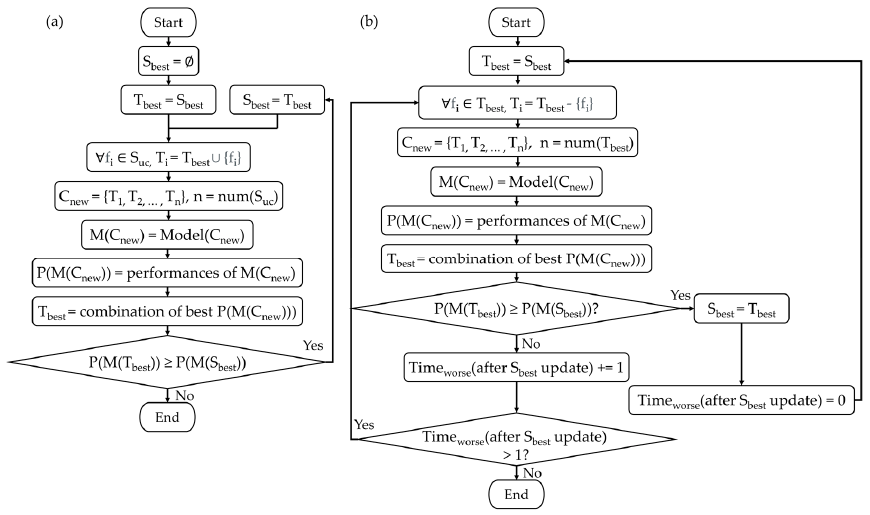
Figure 4. The modeling algorithm workflow. ( a ) Stage 1: feature increment. ( b ) Stage 2: redundant feature removal. The meaning of the symbols are as follows: S best : the feature combination of the best performed model. T best : the feature combination of the stepwise best performed model. S uc : the set of all unselected features. f i : symbol of a feature. C new : a set of all feature combinations in each step. M (combinations): model of the combinations. P (model): performance of the model. Time worse (after S best update): the time that new models perform worse than the current best model on